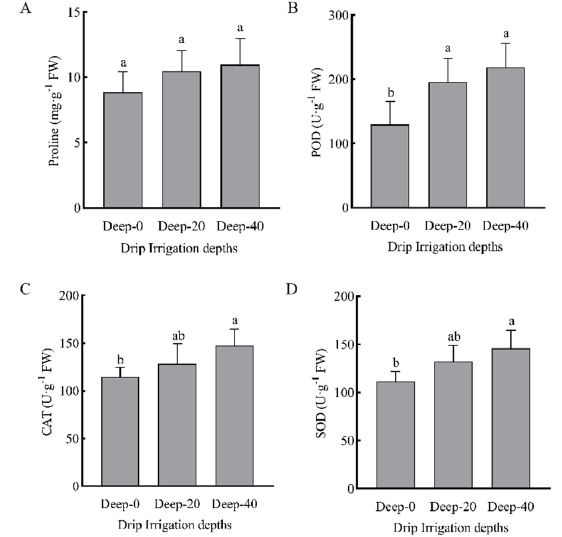
Figure 10. Proline content and antioxidant enzyme activities in the crown of alfalfa plants under three drip irrigation depths. ( A ) Proline, ( B ) peroxidase (POD), ( C ) catalase (CAT), and ( D ) super ‐